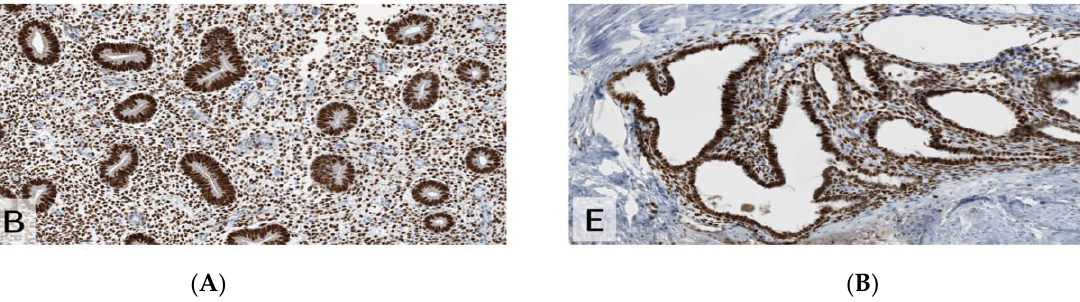
Figure 5. Estrogen receptor (ER) with strong nuclear expression (IRS 12) (×200). ( A ) Endometriosis. ( B ) Endometrium.